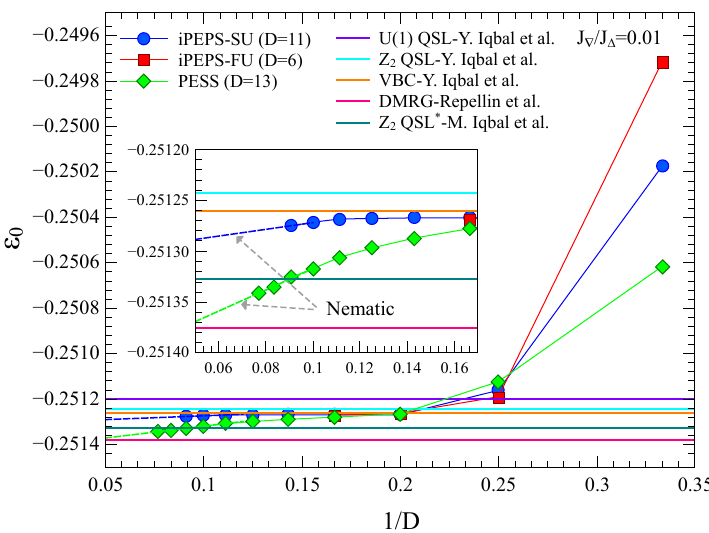
Figure 5: (Color online) Scaling of the iPEPS and PESS ground-state energy per-site with respect to inverse bond dimension D in the large breathing anisotropy limit at J (cid:53) / J (cid:52) = 0.01. Our variational energies obtained with SU, FU and PESS are lower as compared to those of Ref. [ 42 ] for U(1) QSL, (cid:90) QSL and VBC phases and are 2